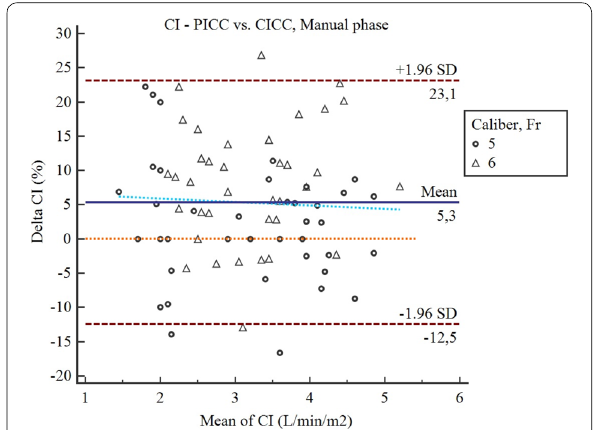
Fig. 2 Bland-Altman plot comparing the difference of cardiac index between CICC and PICC during the manual phase. The solid horizontal line represents the mean bias (%) between the two devices. The two dashed horizontal lines correspond to the limits of agreement (mean bias 1.96 times the standard deviation of the ± differences)